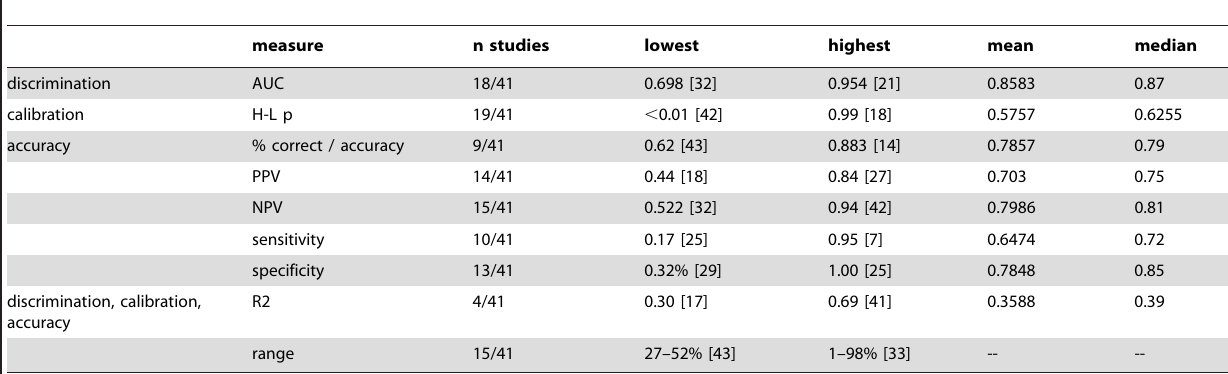
Table 1. Summary of performance measures reported in the 41 development studies.